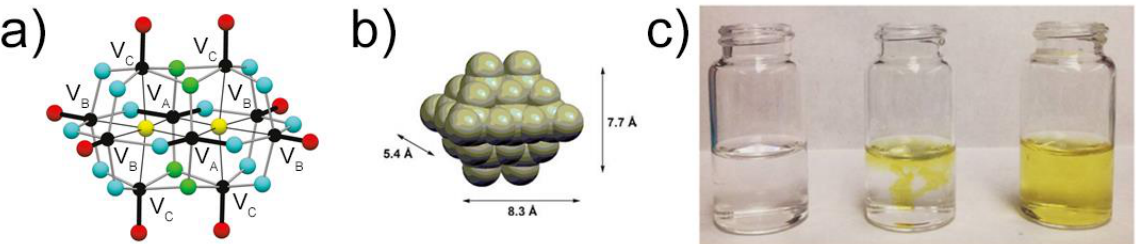
Figure 1. Illustration of the structure of V 10 ion V 10 O 28 6− (abbreviated V 10 ): ( a ) schematic drawing showing the three different types of octahedral V atoms (black circles), non-oxido V A , and two different surface active V B and V C atoms; [1]-coordinated O atoms = red circles, [2]-coordinated O atoms = blue circles, [3]-coordinated O atoms = green circles, [6]-coordinated O atoms = yellow circles, V–O vanadyl bonds = thick black line, V–O trans bonds = thin black line, V–O equatorial bonds = grey shaded line; ( b ) space-filling diagram of a typical V 10 anion and ( c ) three vials from left containing colorless oxidovanadates, colorless oxidovanadate solution with a drop of acid added forming yellow V 10 and yellow V 10 solution. Images used were obtained with permission from ( a ) Ref. [28] © 2019 by the Minerological Association of Canada, ( b ) Ref. [29] © 2014 by the World Scientific Publishing, and ( c ) Ref. [30] © 2022 by Elsevier.